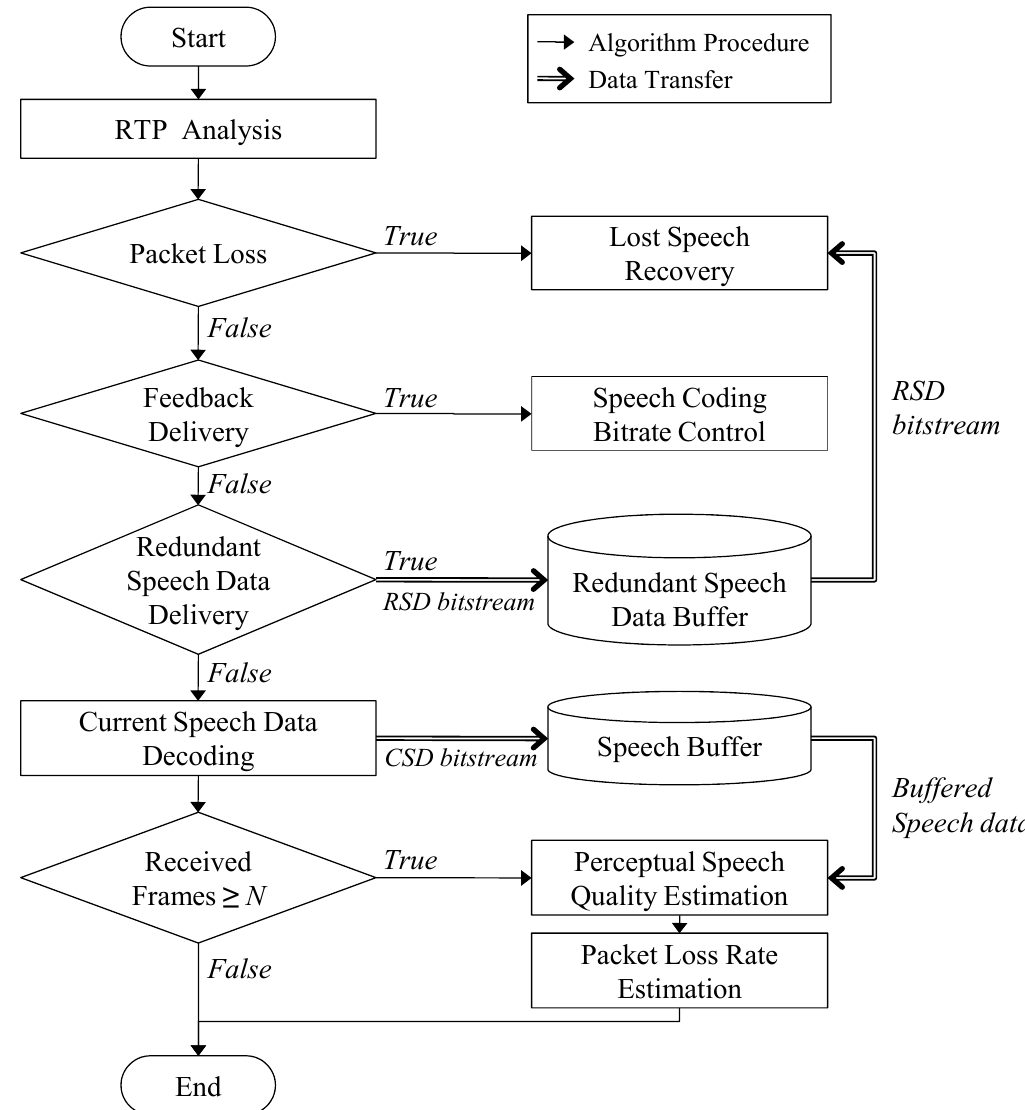
Figure 5. Procedure of the packet loss recovery with the PSQ estimation at the receiver